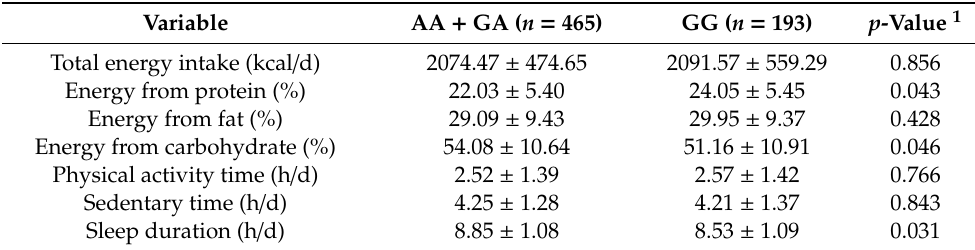
Table 6. Energy intake, physical activity, and sleep duration compared by genotypes in boys.